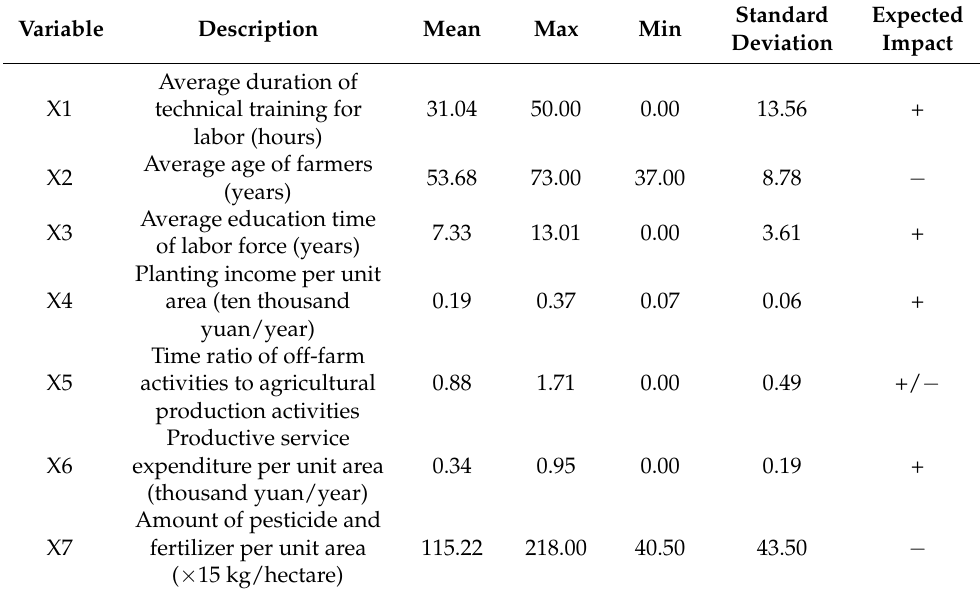
Figure 5. The relationship between farmers’ production efficiency and influencing factors. Table 4. Statistical description of factors that influence efficiency and their expected